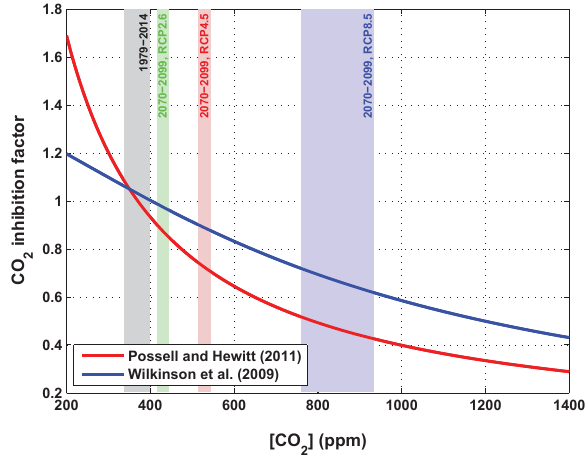
Figure 1. Dependence of the CO 2 inhibition factor on ambient CO 2 concentrations following the Wilkinson et al. (2009) and Possell and Hewitt (2011) parameterizations. The vertical bands show the ranges of CO 2 concentrations for the historical simulations and fol- lowing the different RCP scenarios.